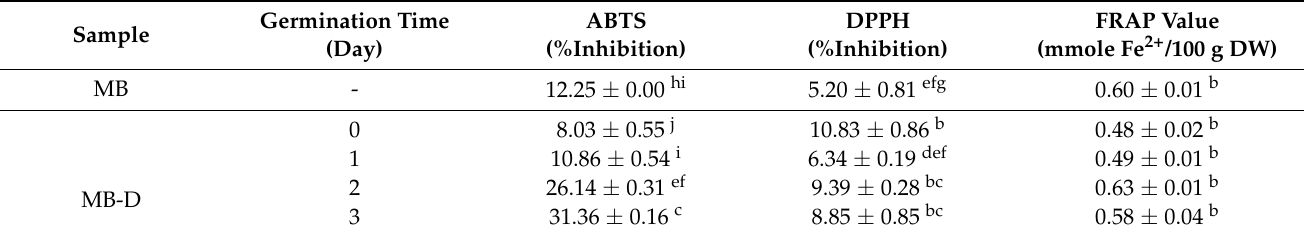
Table 2. Antioxidant capacity of mung bean seeds (MB) and sprouts germinated in darkness (0/24